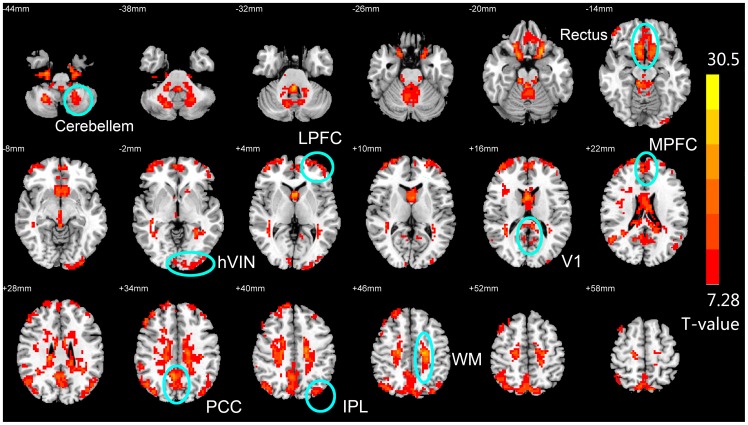
F-map (Q<0.001, FDR corrected) representing brain areas whose ReHo are significantly frequency-dependent.Key brain areas survived the FDR correction are marked with a circle and the names (abbreviations) of these areas are indicated beside the circle. Abbreviations: posterior cingulate cortex (PCC)/precuneus, bilateral inferior parietal lobule (IPL), lateral prefrontal cortex (LPFC), primary visual area (V1), higher-order visual network (hVIN), sensory motor network (SMN), and white matter (WM).